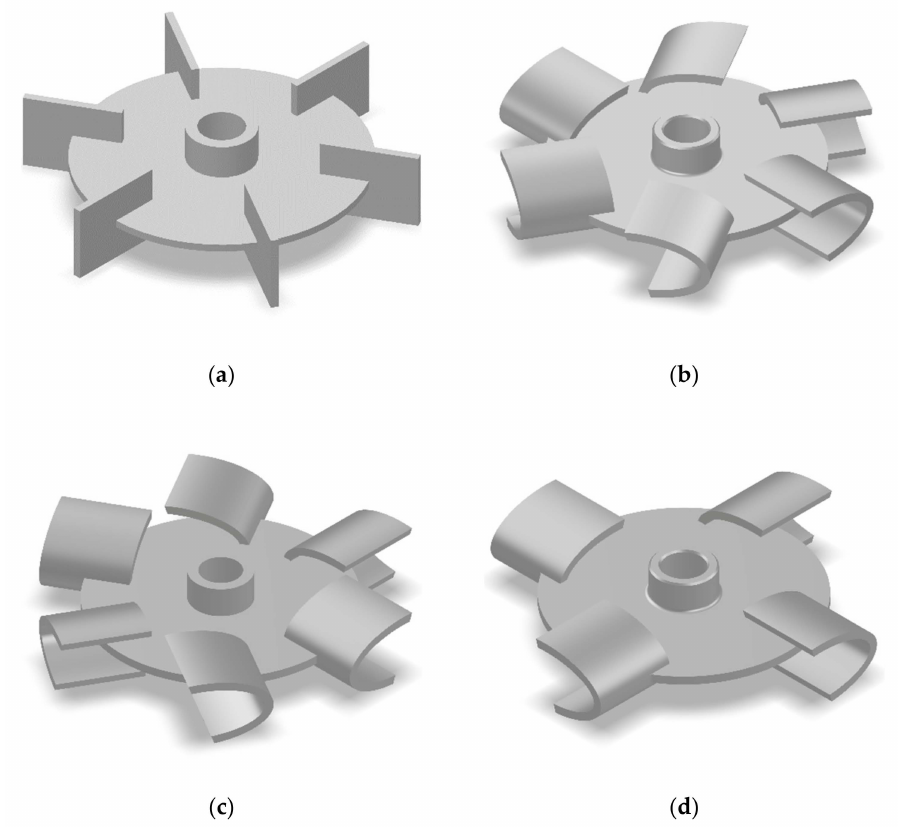
Figure 2. Impellers ( a ) Rushton turbine (RT) ( b ) BT-6 ( c ) BT-33 ( d )